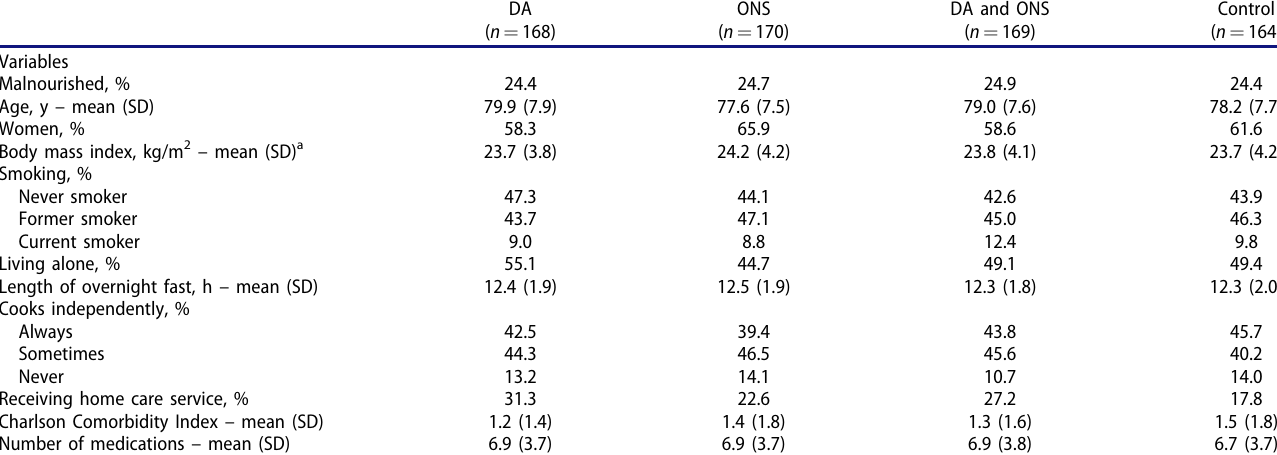
Table 2. Characteristics of the 671 participants at baseline.